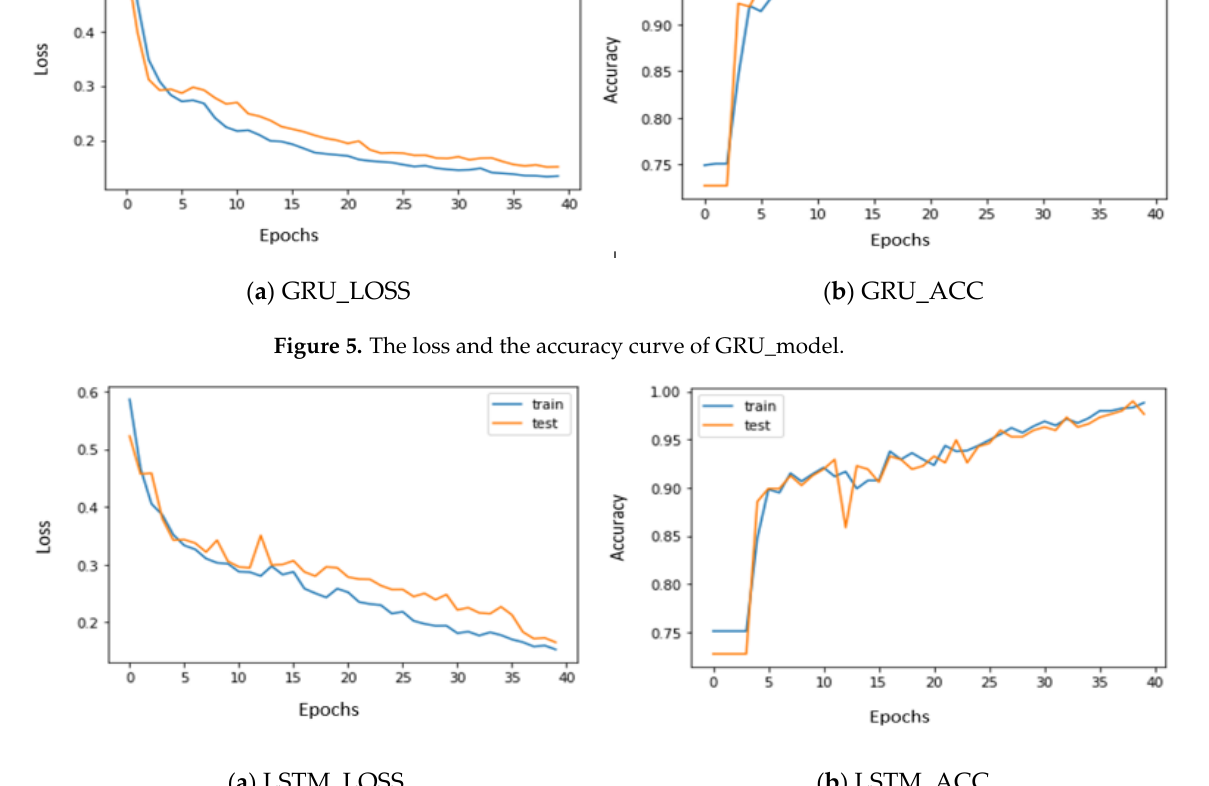
Figure 7. The confusion matrix curve of the LSTM and GRU models. 5.3. Decision-Level Fusion Using Hard Voting Classifier The voting ensemble model performs well when compared to the performance of the individual models. The performance was improved by the combination of LSTM and GRU, both of which performed well on their own. According to the experimental results, the proposed voting ensemble model, LSTM + GRU, surpasses all other models and achieved the greatest accuracy of 98.0%. Figure 8 shows the confusion matrix curve of the hard voting model (GRU-LSTM).